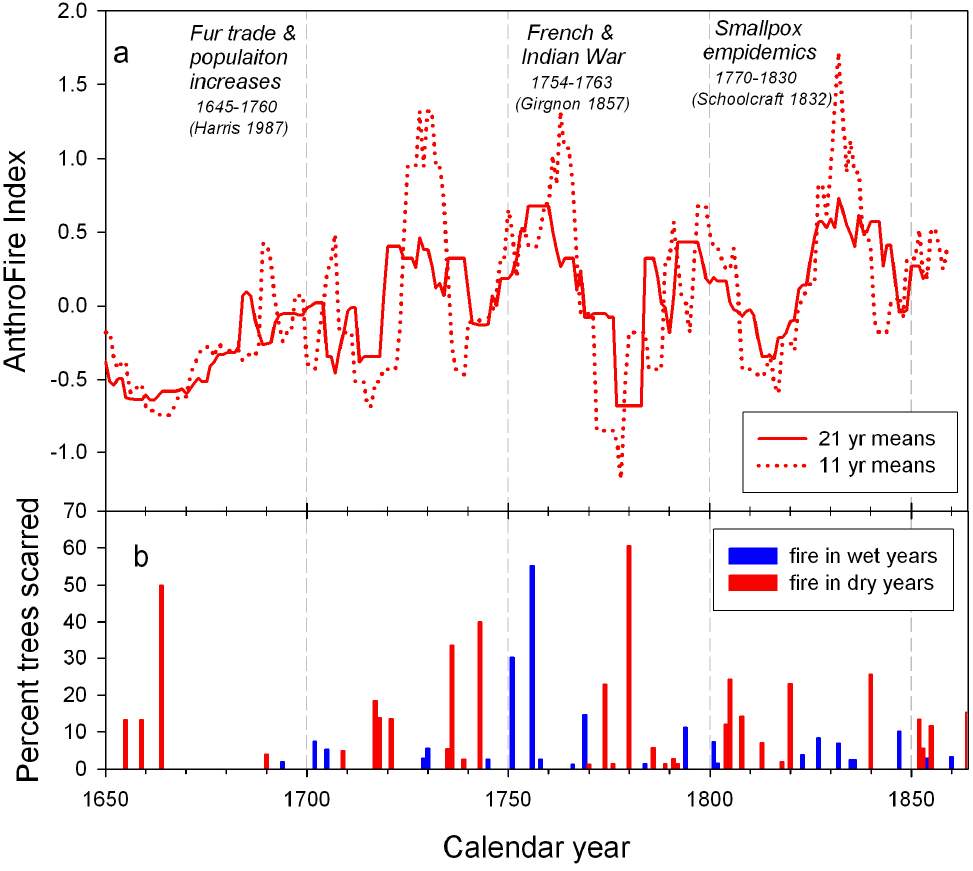
Figure 6. ( a ) Running means (21- and 11-year) of the AnthroFire Index (AFI). Larger AFI values indicate increasing human influence based on the occurrence of fire in ‘wet’ years and the absence of fire in drought years. The text identifies possible factors and periods of regional human influence in the fire regime of Northeastern Sands Ecological Landscape [23,38,39]. ( b ) Time series of the percent of trees scarred and reconstructed drought conditions (blue for wet years (PDSI > 0 and red for dry years PDSI < 0).